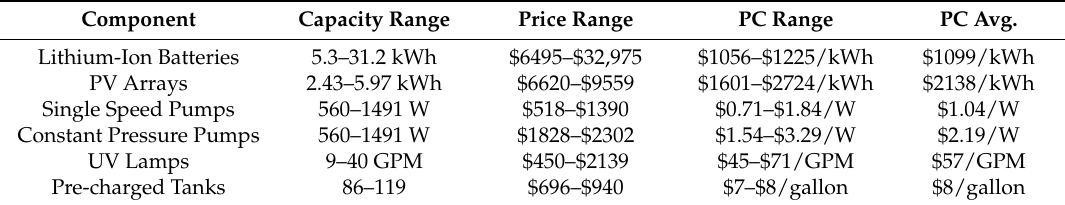
Table 10. Ranges of capacity, price PC and PC average for system